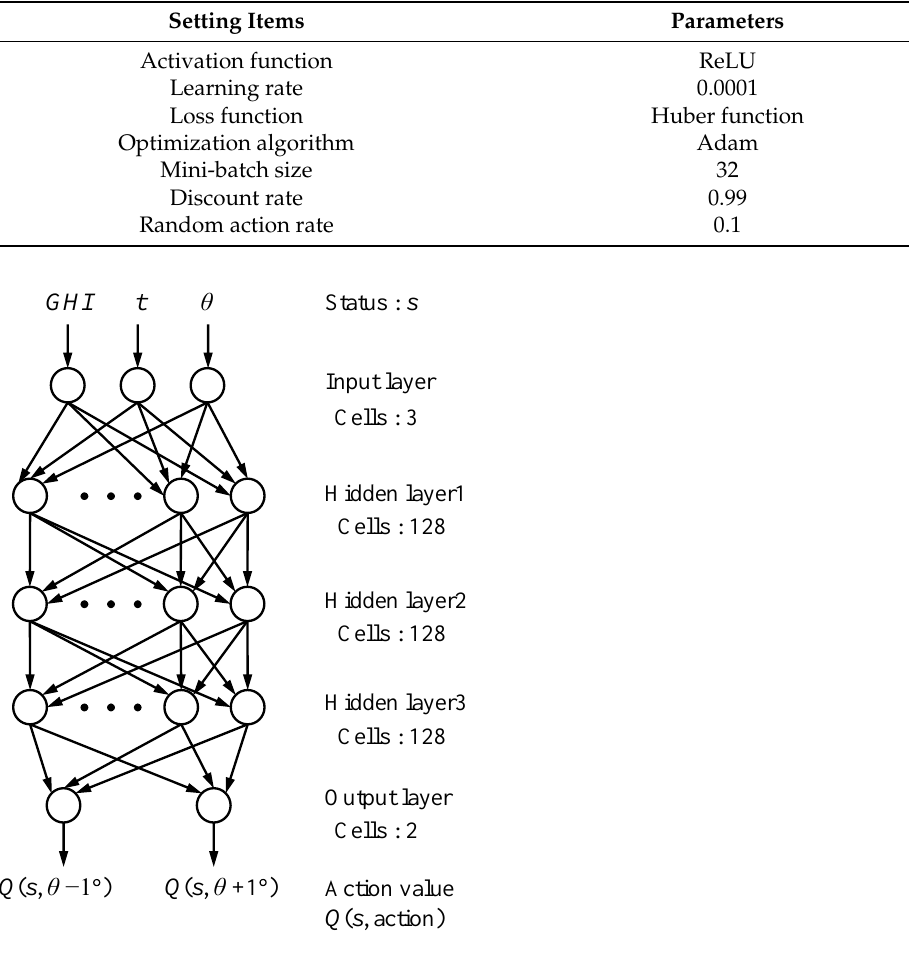
Figure 4. Schematic of the deep neural network. Table 2. Reward settings for deep reinforcement learning.